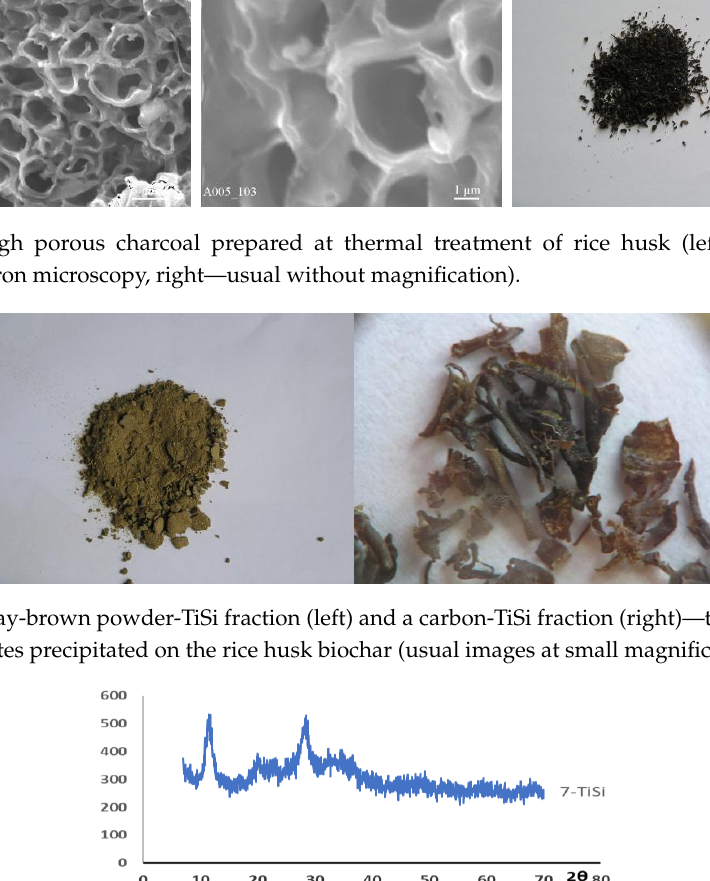
Figure 4. X-rays diffraction analysis of the TiSi-powder fraction of the sample 7 (Cu Kα).